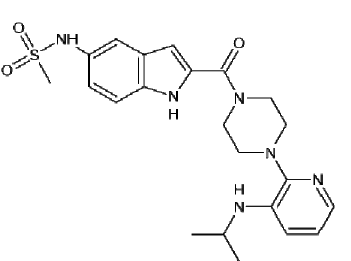
Figure 9. Delavirdine: Anti-HIV